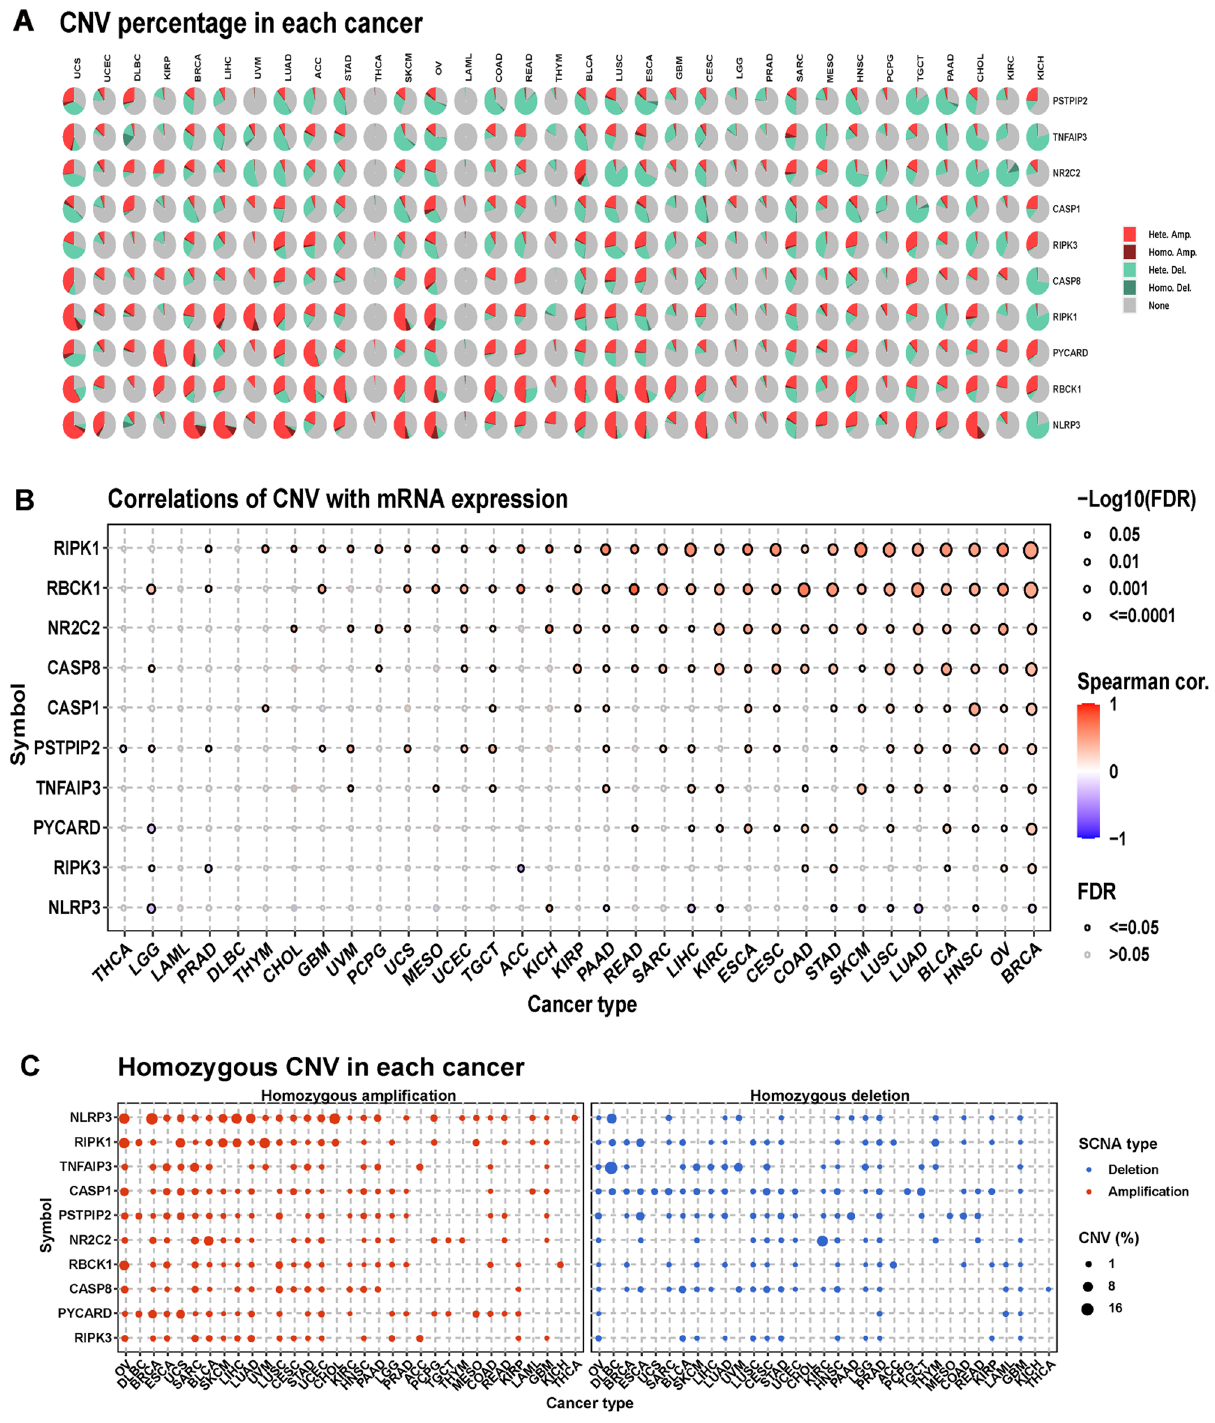
Figure 5. The CNV and methylation levels of PANoptosis genes in pan-cancer. ( A ) Pie plot displays the global CNV profile of PANoptosis genes in 33 cancer types. ( B ) The correlation between CNV and genes mRNA expression in TCGA pan-cancer samples. ( C ) The profile of homozygous CNV shows the percentage of amplifications and deletions of homozygous CNV for genes in each cancer. ( D ) The profile of heterozygous CNV shows the percentage of amplifications and deletions of heterozygous CNV for genes in each cancer. ( E ) Methylation difference between tumor and normal samples in indicated tumor types. ( F ) The correlation between methylation and genes mRNA expression in TCGA pan-cancer